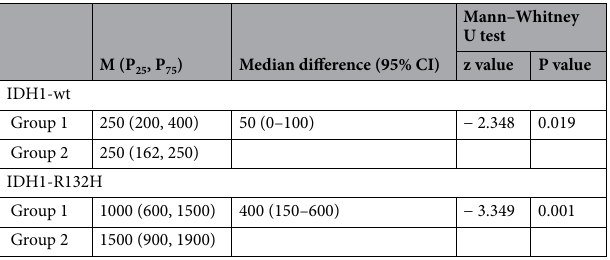
Table 8. Comparison of relative fluorescence value in two